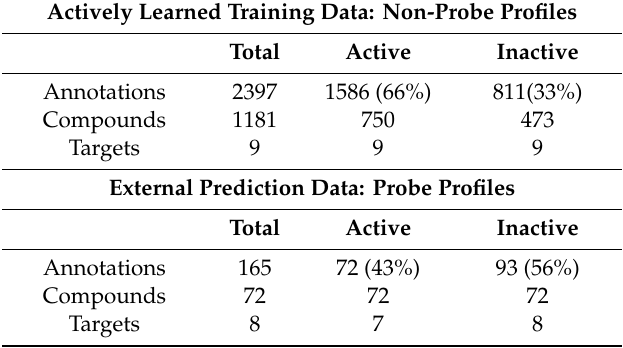
Table 1. Sizes of MMP non-probe (training) and probe (external prediction) datasets used in the study.